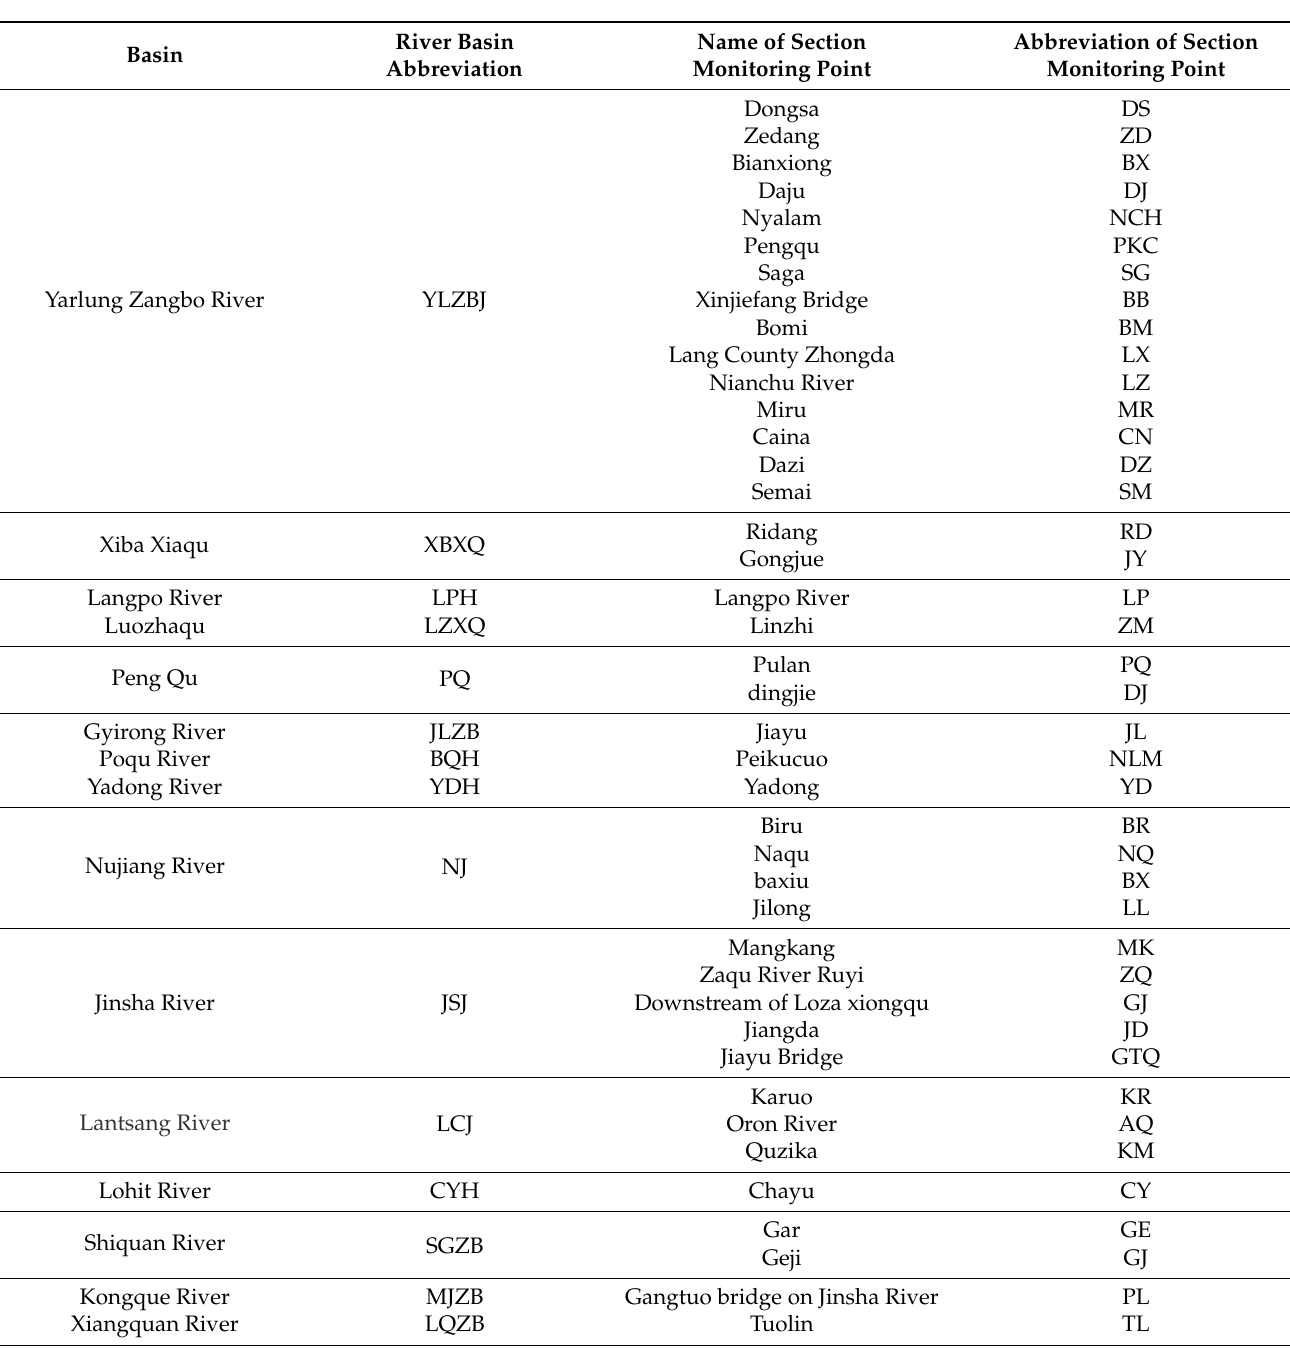
Table 1. Basic information of monitoring